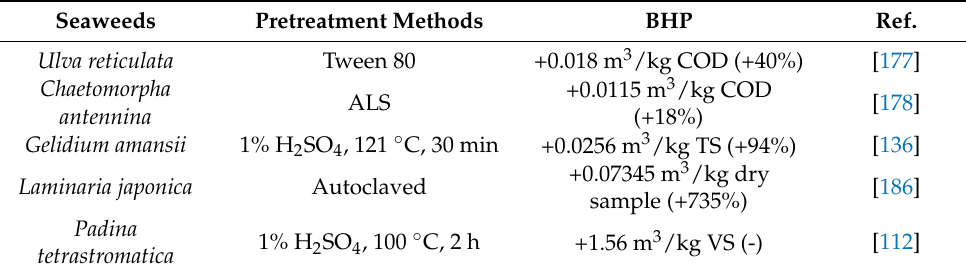
Table 5. Improvement of BHP of seaweeds through the employed pretreatment